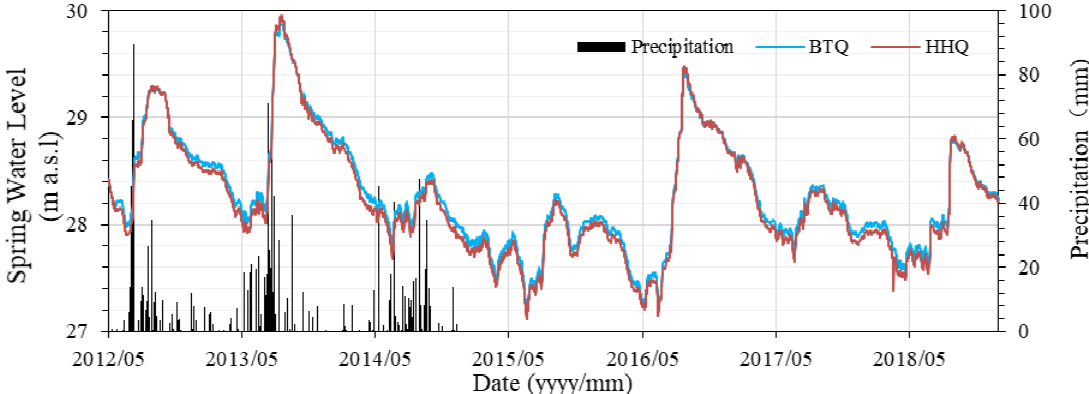
Figure 3. Plots of monthly precipitation and the daily water level of Baotu Spring (BTQ) and Heihu Spring (HHQ).